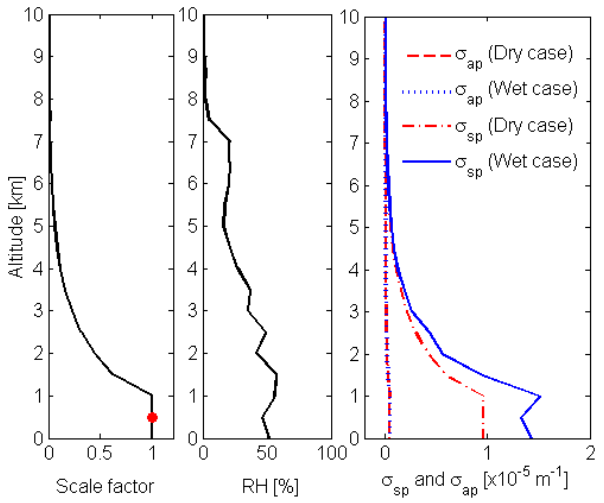
Figure 11. Vertical profile of (a) scale factor for particle num- ber size distributions, the red point shows the level of the station. (b) Ambient RH measured by soundings. (c) σ sp and σ ap m − 1 , modeled for the Dry and Wet cases for 11 April 2008 at the Zep- pelin station.